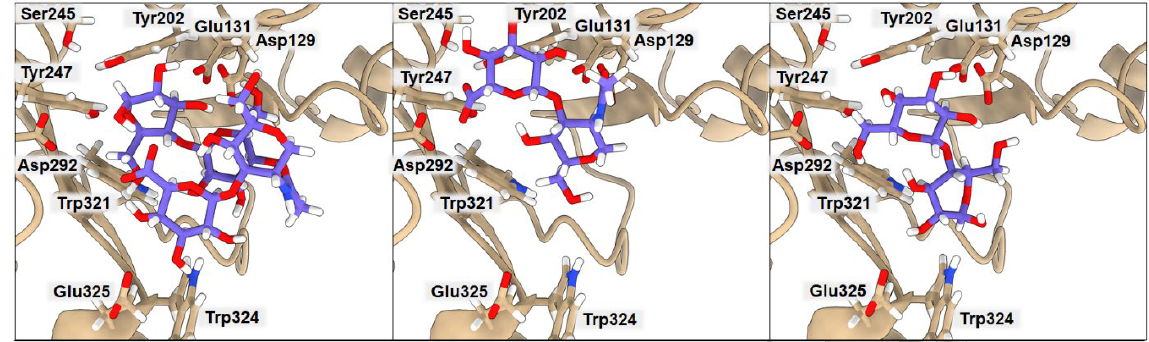
Table 5. Binding affinity (BA) in kcal·mol −1 computed for HA-CB, HA, and CB bound to hHyal-1 and key distances in Å between Hyal-1 amino acids and ligands. Hydrogen bonds are marked in bold.